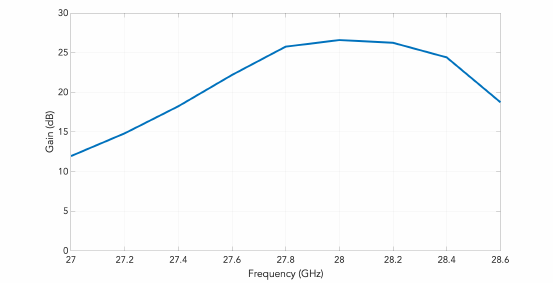
Figure 10. Simulated realized gain of the array of horns fed the 2D transverse waveguide slot array as a function of the